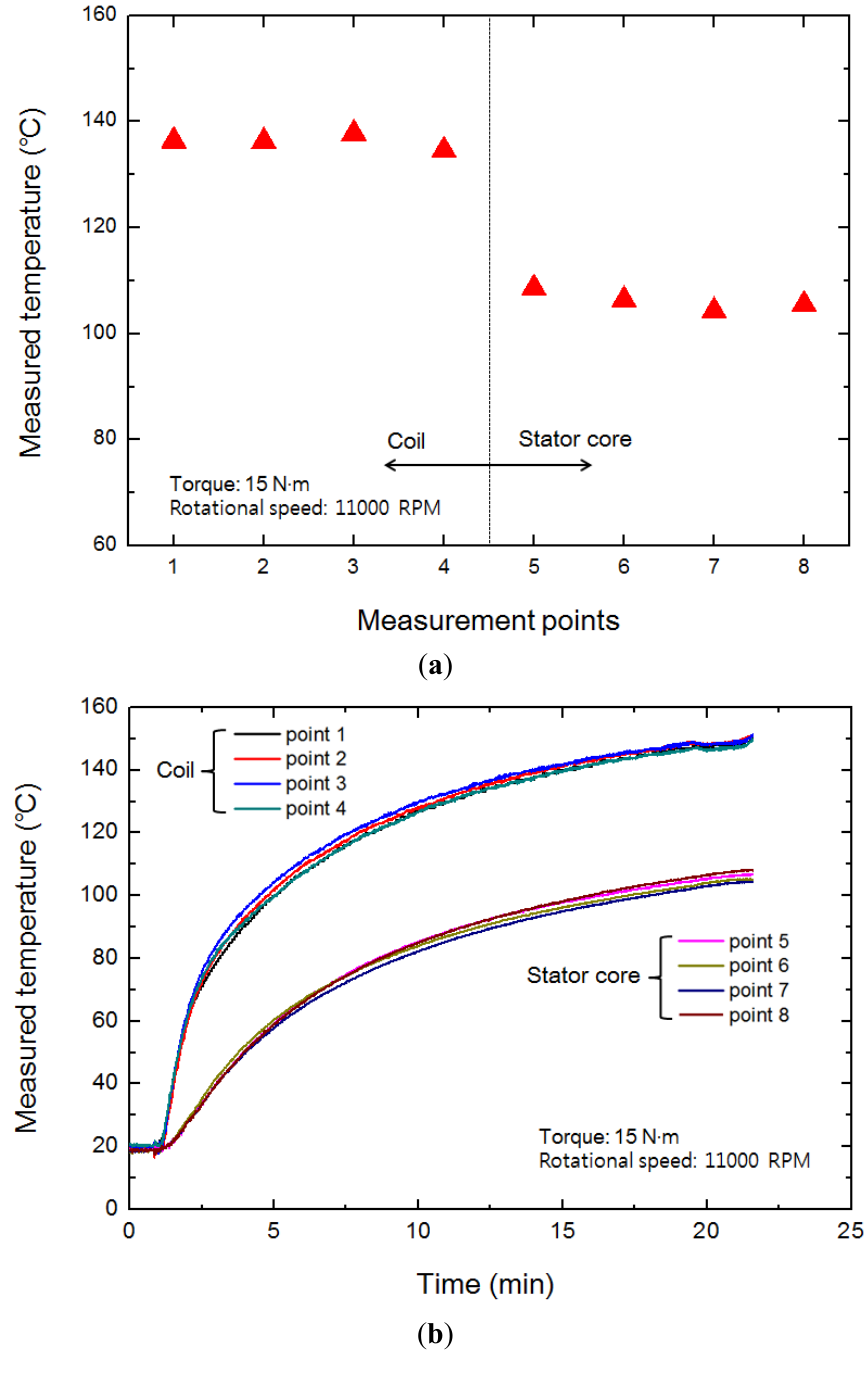
Figure 6. Temperature comparison of motor cooling systems under conditions of continuous-rating maximum speed: ( a ) steady-state temperatures with radiator and ( b ) transient temperatures without a